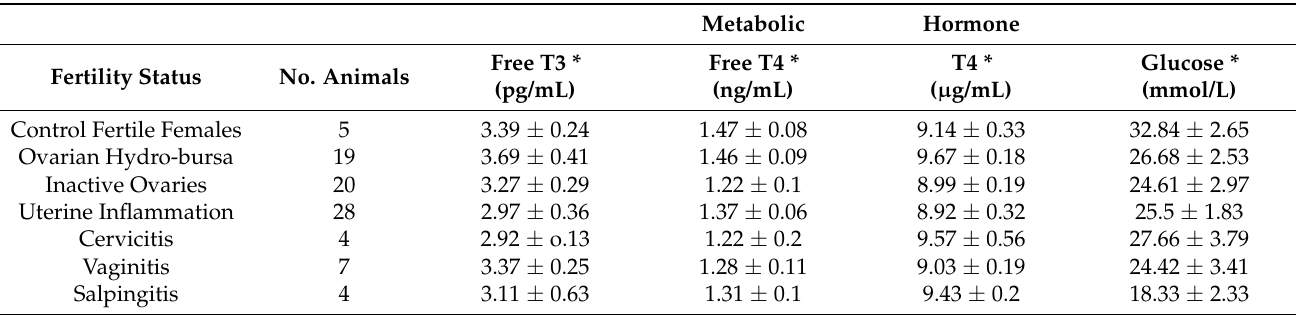
Table 3 exhibits the data of the cytokines and antioxidants in fertile and subfertile female dromedaries. Transforming growth factor ´ α (TGF´ α ) concentration was not different ( p > 0.05) among groups. Contrariwise, interleukin ß (IL-ß) concentration differed ( p < 0.05) among female groups. IL-ß concentration was high ( p < 0.05) in the females suffering from ovarian hydro-bursa (BU; 10.83 pg/mL), cervical inflammation (CE; 11.69 pg/mL), and vaginal inflammation (VA; 8.59 pg/mL), and medium in fertile females (CON; 4.87 pg/mL), females having uterine inflammation (EN) and Fallopian tubes adhesions (SA; 3.18 and 3.25 pg/mL, respectively) and low in the case of inactive ovaries (IO; 0.26 pg/mL). Reduced glutathione (GSH), as an antioxidant, revealed the highest ( p < 0.05) concen- tration in the fertile females (491.94 µ mol/L), followed by the females having cervicitis (CE; 473.04 µ mol/L), but both these two groups surpassed ( p < 0.05) the other infertile groups (Table 3). Nitrous oxide (NO) concentration revealed significant ( p < 0.05) elevation in the control females, accounting for 2–8 folds of its counterpart levels in the infertile females. Females with ovarian abnormalities (BU and IO) have demonstrated the lowest concentrations of NO among other infertile groups (Table